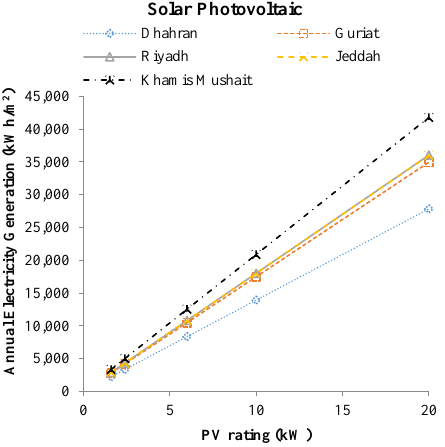
Figure 8. The electricity generation from various solar PVs for all locations.